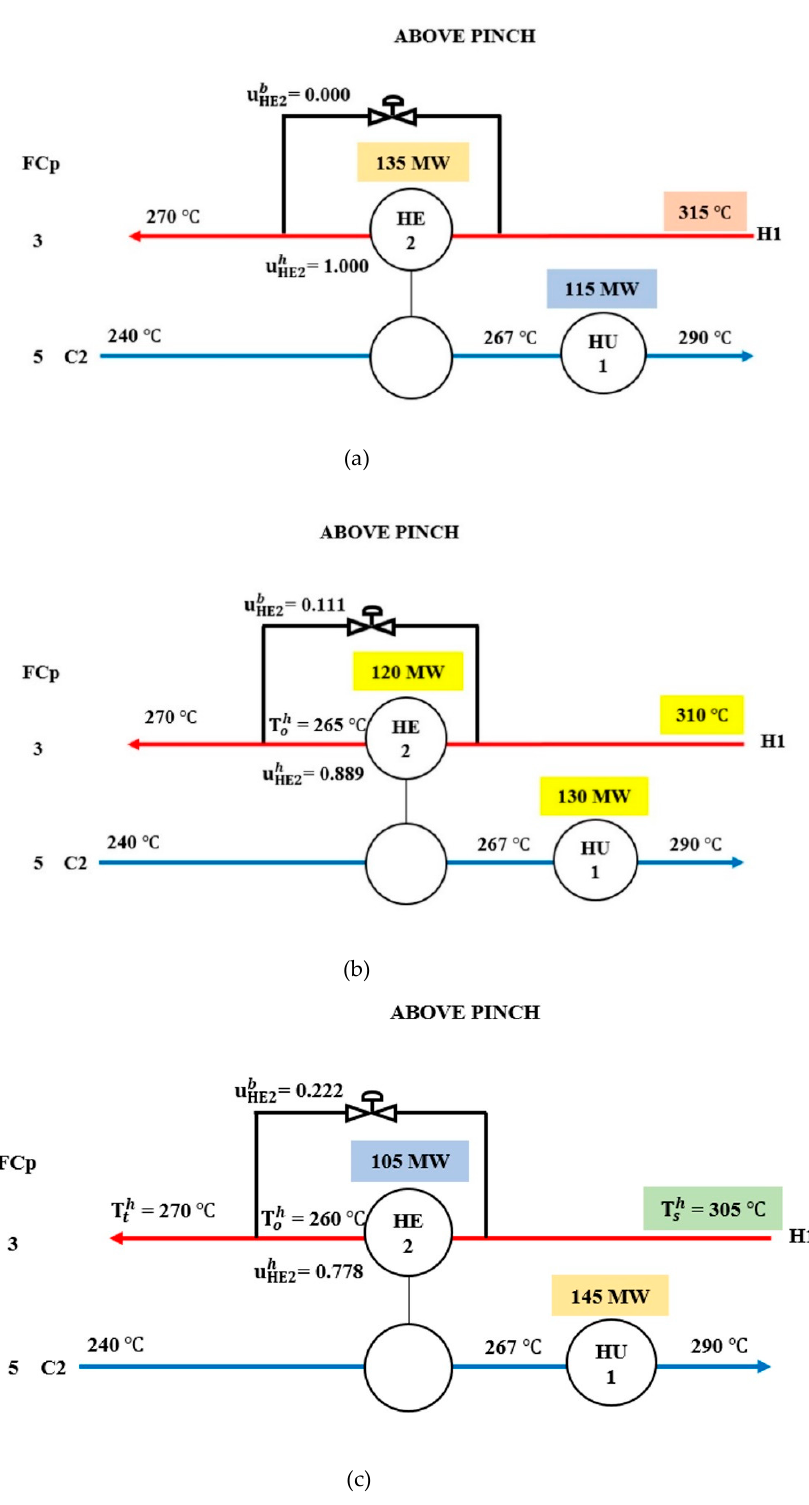
Figure 16. ( a ) HEN design with T S increase by 5 ℃ for H1. HE2 is designed with a bigger area to accommodate up to 135 MW heat duty; ( b ) HEN design for nominal T S for H1. HE2 is designed with a bigger area and 120 MW heat duty; ( c ) HEN design with T S decrease by 5 ℃ for H1. HE2 is designed with bigger area and 105 MW heat